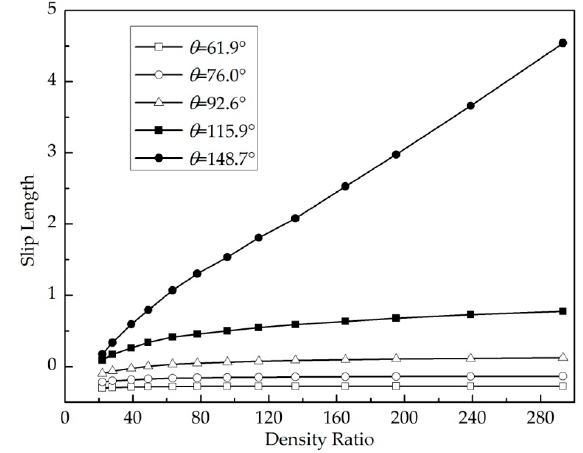
Figure 12. Slip length against liquid-gas density ratio.